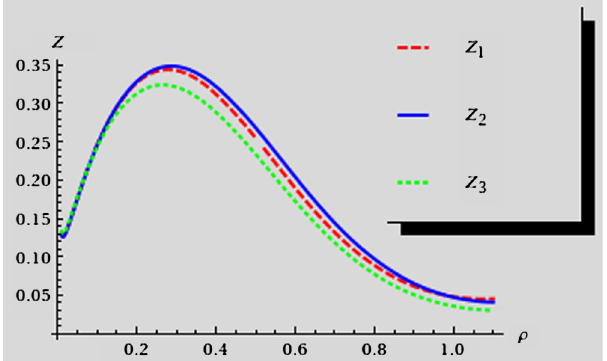
FIG. 10. Radial profile of the enstrophy at the horizon, for a vortex solution, as calculated by Eq. (A24), the square of the Pontryagin density [12], and ½=ð (cid:8) Z , respectively). Each curve has been rescaled by a trivial 3 constant factor for easier